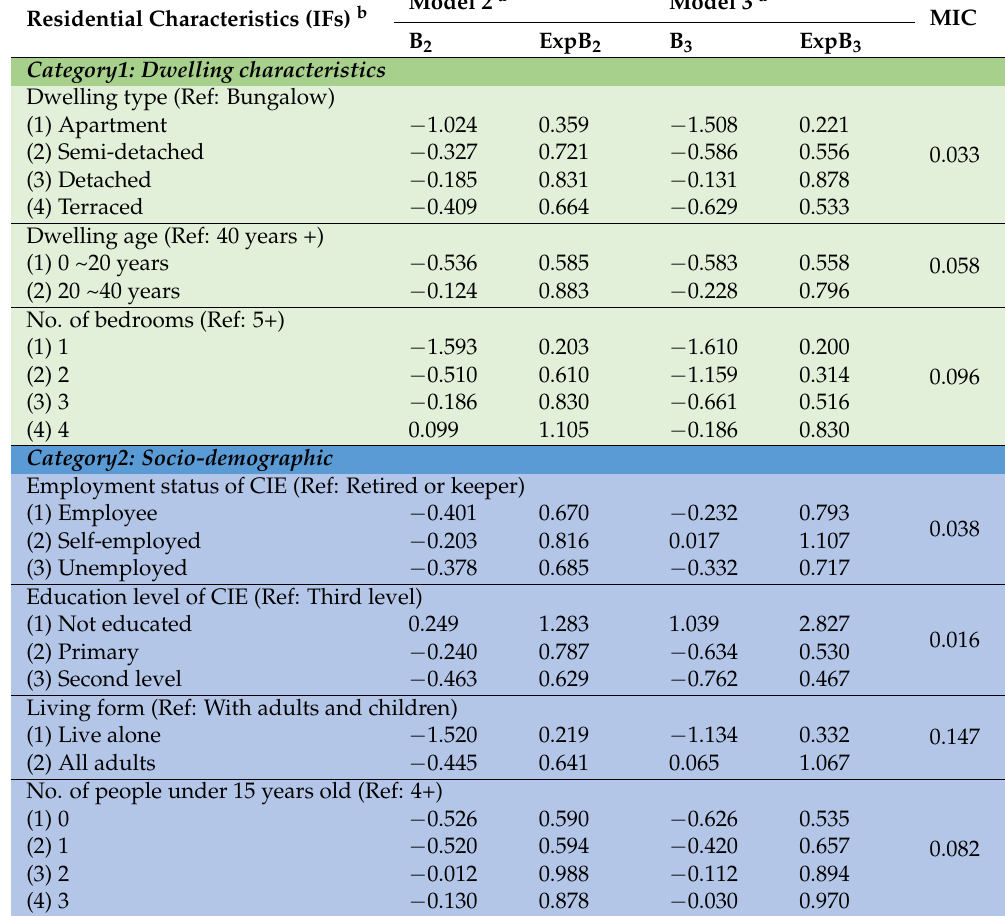
Table 2. Overview of multinomial logistic regression results and